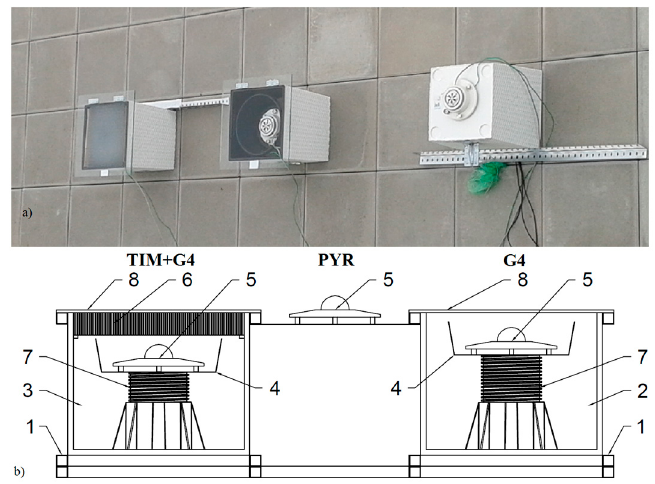
Figure 3. Total solar transmittance outdoor setup; ( a ) TIM + G4 and G4 test boxes and standalone PYR sensor; ( b ) proposed testing scheme: (1) measurement apparatus; (2) reference box; (3) metering box; (4) round bowl; (5) solar radiation intensity sensor; (6) measured sample space; (7) height adjustable screw; (8) protective layer, glass pane.